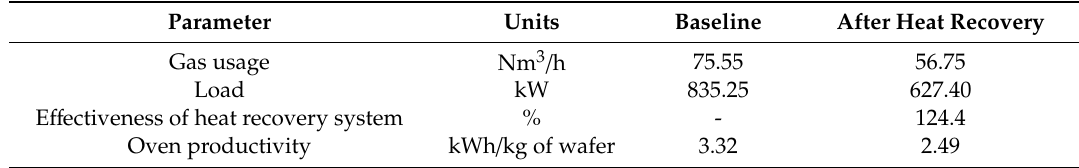
Table 8. Key performance indicators of the industrial-scale baking oven before and after heat recovery to reheat returning process